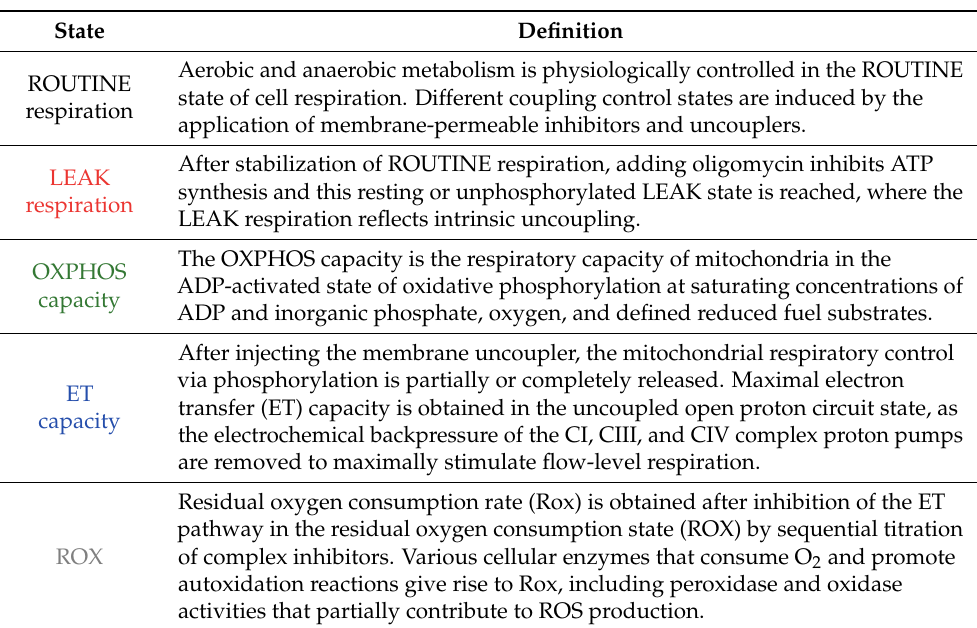
Table 5. Definition of coupling states used for mitochondrial energetics